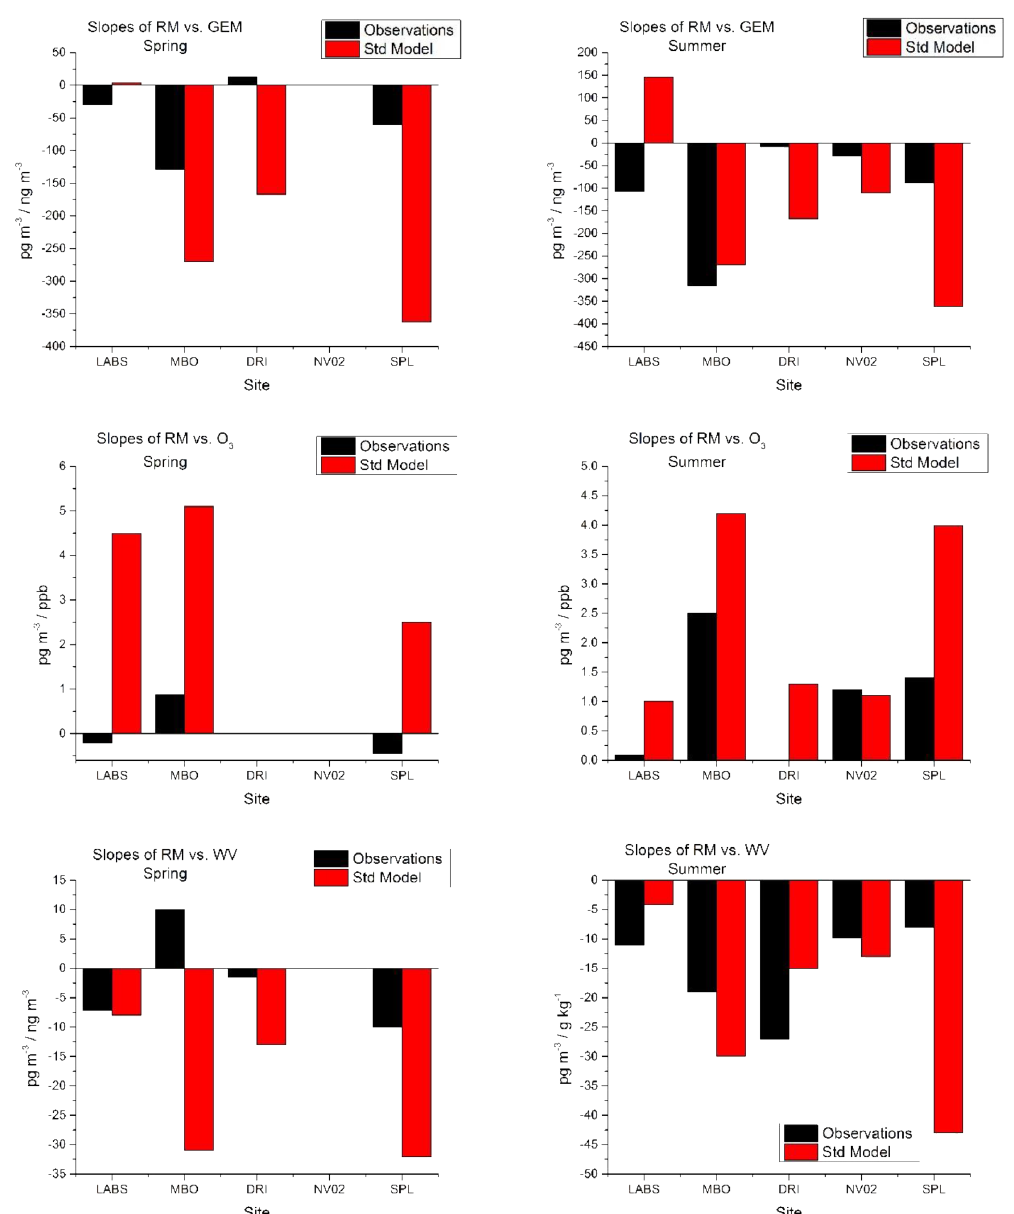
Figure 2. Slopes from the linear regressions of observed and standard-modeled RM vs. GEM, RM vs. O 3 , and RM vs. water vapor daily mean concentrations for each site and season. Observed data were filtered using only data when WV is less than the 75th percentile. Winter and fall data not shown. All linear regression statistics given in Table